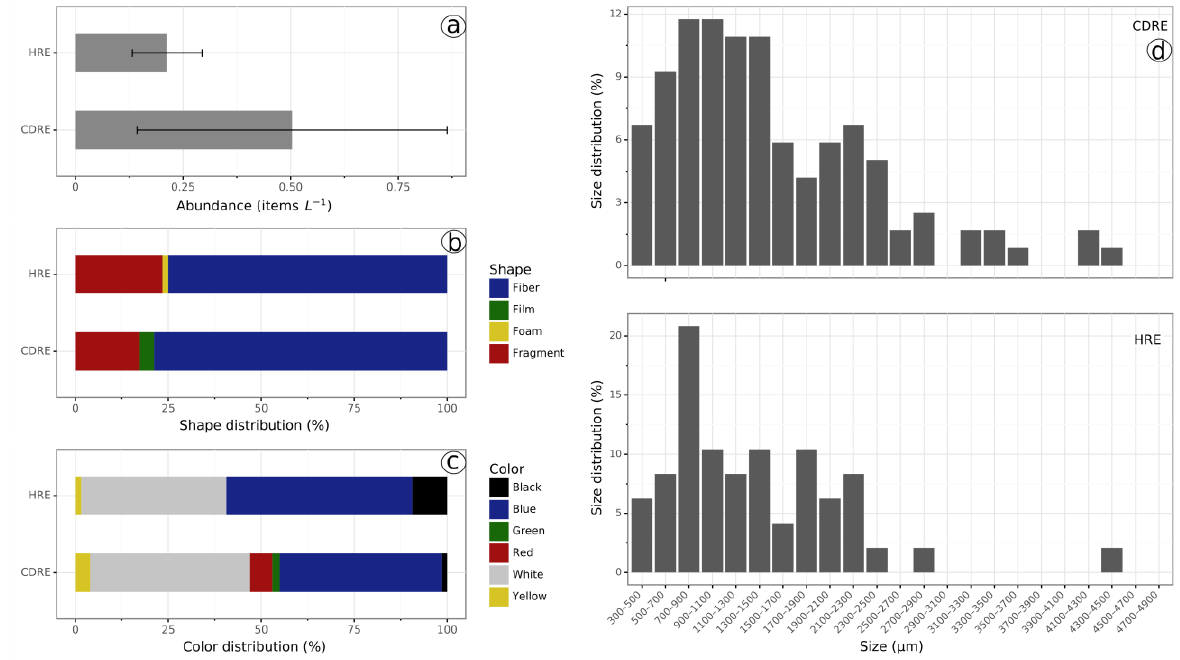
Figure 5. Microplastic characteristics in the water of Han River Estuary (HRE) and Cu De River Estuary (CDRE): ( a ) abundance; ( b ) shape distribution; ( c ) color distribution; and ( d ) size distribu-